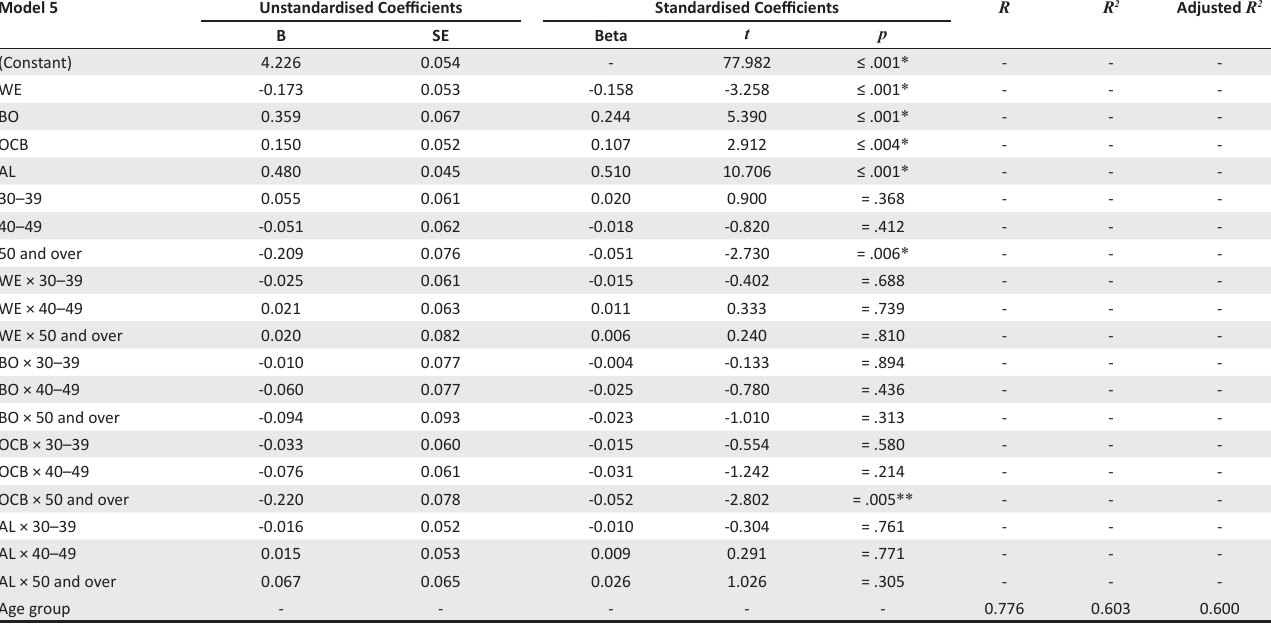
TABLE 4: Moderated multiple regression in terms of age group.